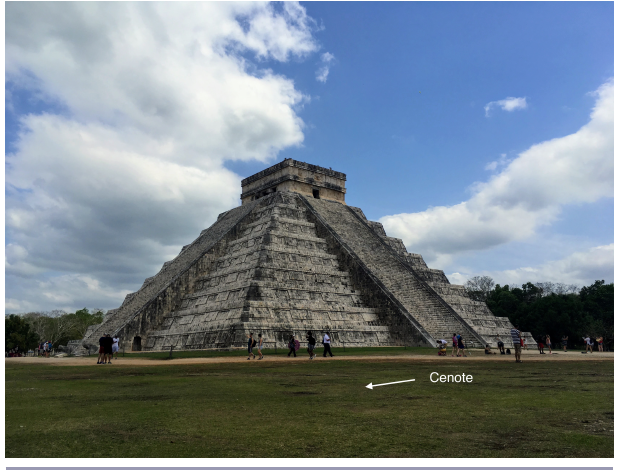
Fig. 3 . Photo of “El Castillo” in Chichen Itza, one of the greatest Maya centers of Yucatan. The arrow indicates the approximate location below the pyramid where the cenote was found. Photo: Y.